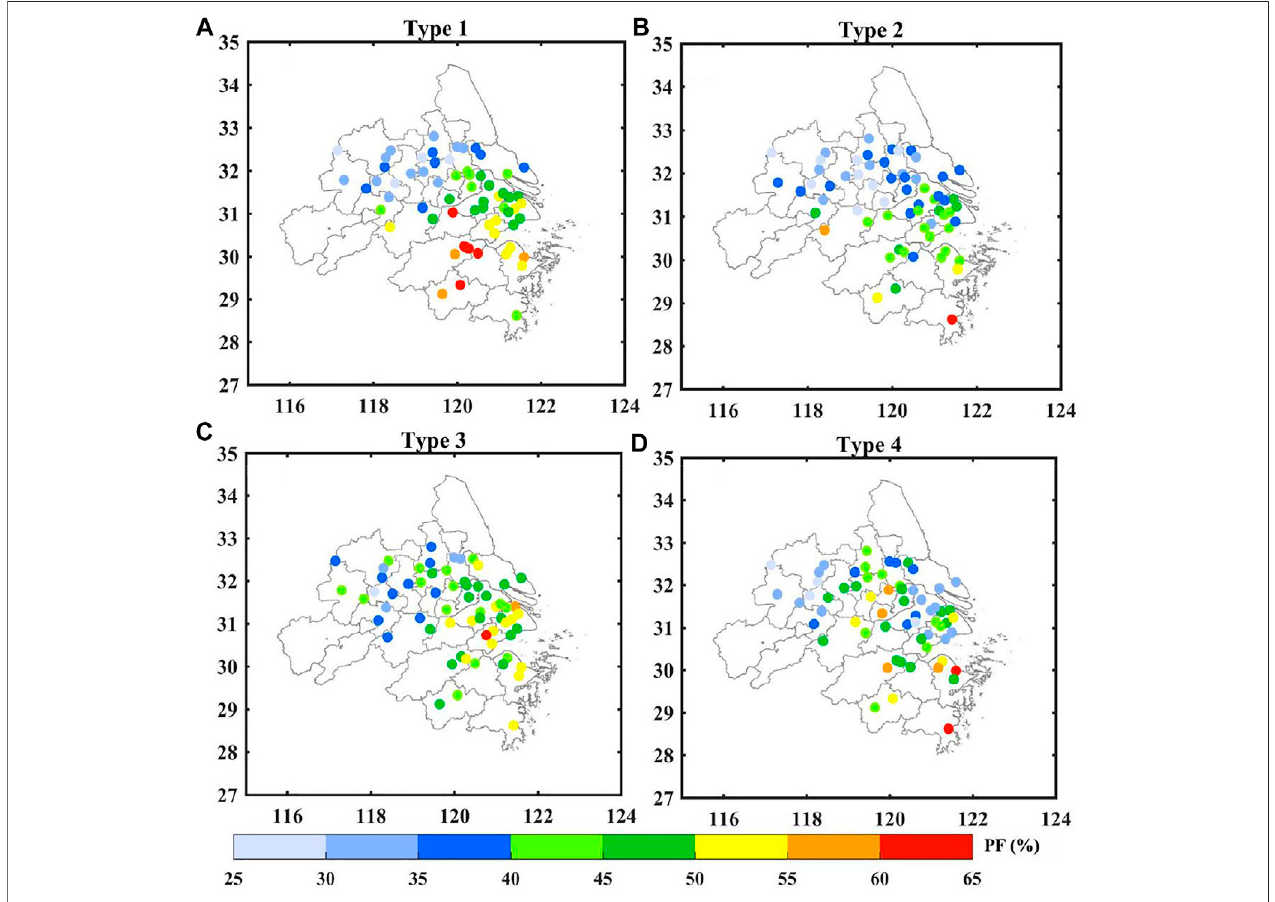
FIGURE 14 | As in Figure 9 but for mean precipitation frequency (PF (cid:2) D P / D T × 100%, where D P is the number of days of precipitation, and D T is total number of days).